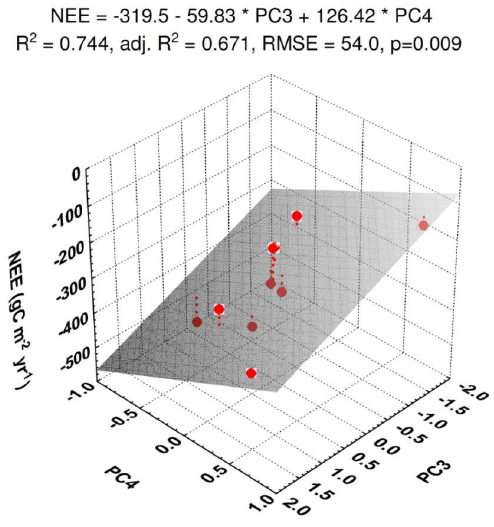
Figure A4. 3D scatter plot of NEE versus the principal component PC3 and PC4 .